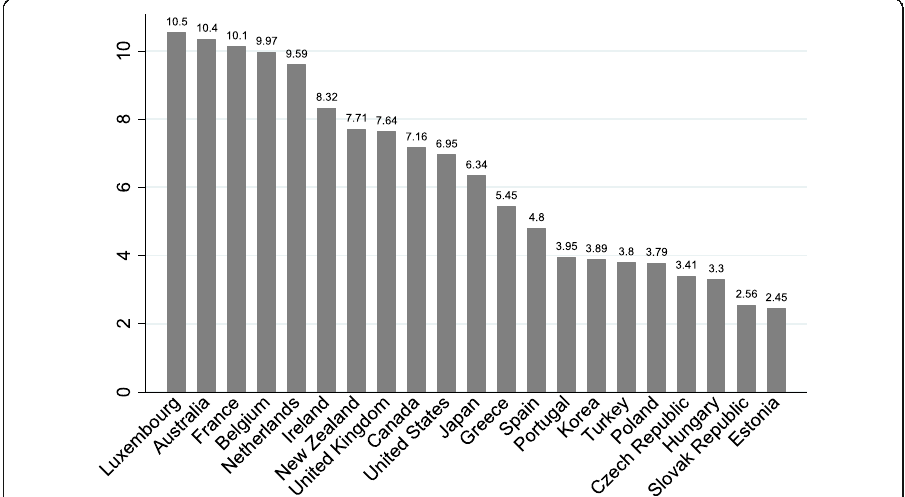
Fig. 1 Average hourly adult minimum wages, $US 2014